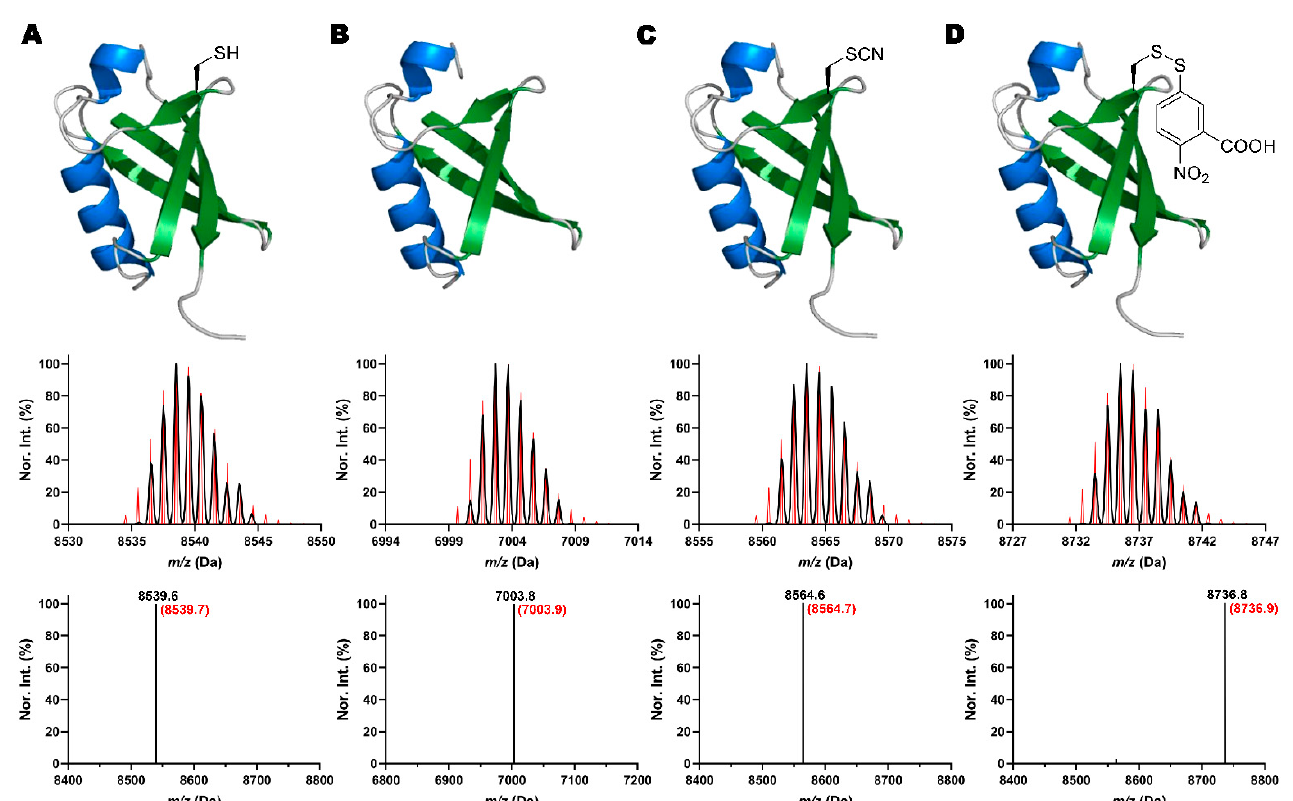
Figure 4. Shown as an example for seven lysine to cysteine mutants of Ub, structures and their corresponding deconvoluted and integrated ESI-MS spectra of ( A ) Ub-K33C, ( B ) the hydrolysis product of Ub-K63C, Ub (1-62) , ( C ) the cyanylation intermediate of Ub-K33C, and ( D ) the TNB adduct of Ub-K33C. In deconvoluted MS spectra, black lines show the detected monoisotopic mass peaks and their relative intensities. Red lines refer to the calculated theoretical monoisotopic peaks and their relative intensity. In integrated MS, experimental and theoretical values are labeled as black and red, respectively.